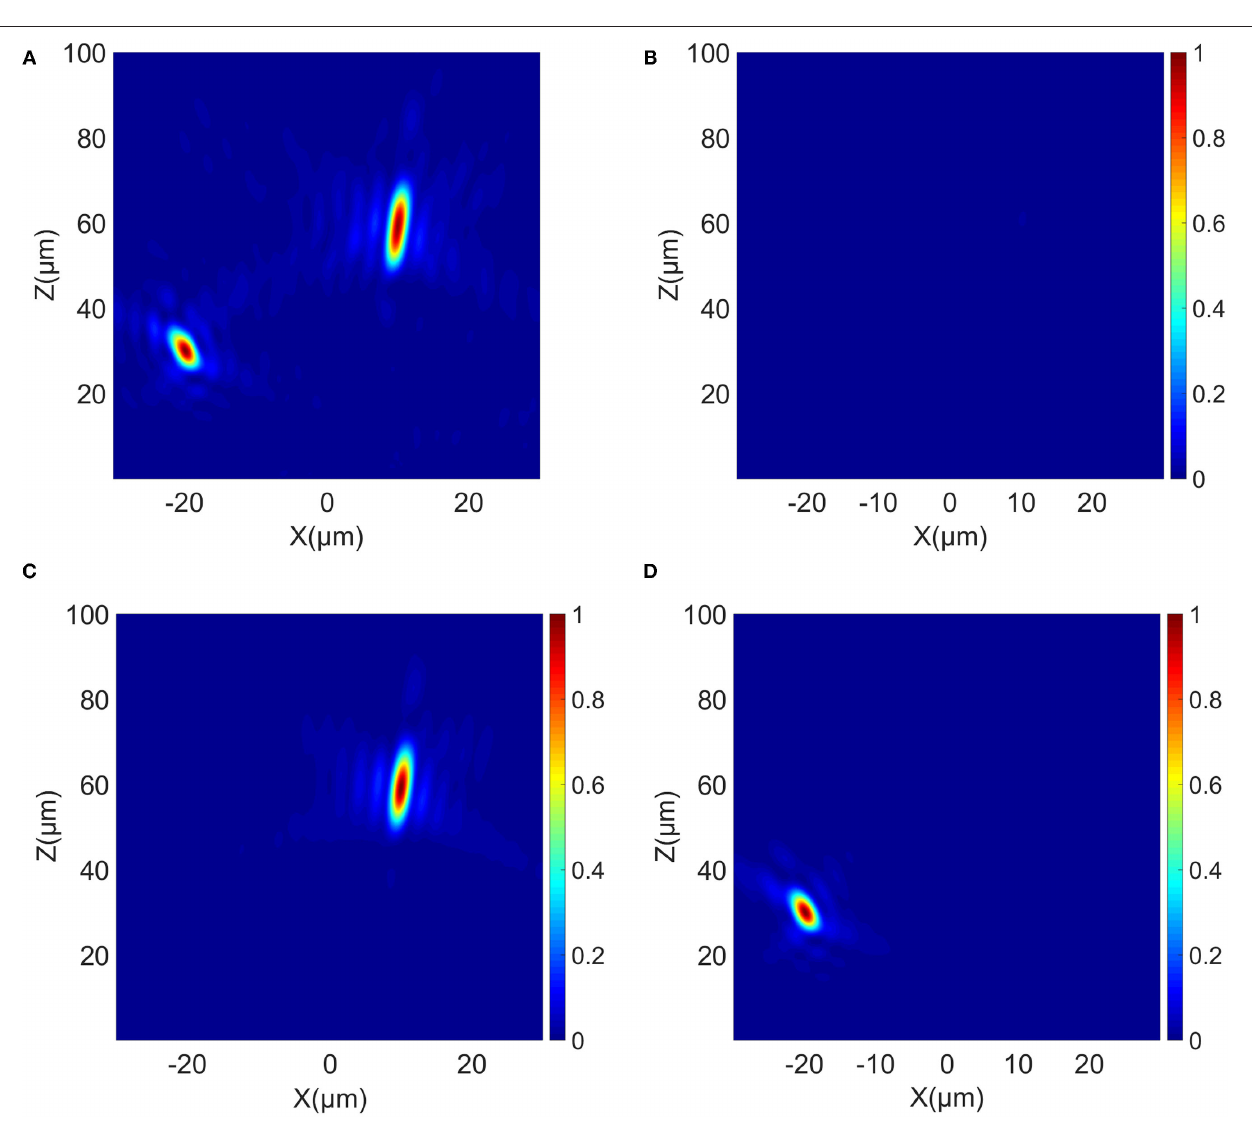
FIGURE 6 | (A–D) Electric field intensity profile for different state of VO 2 , Designed focal position: f ′ A ( pass state. (B) For x-polarized incident light in the close state. (C) For LCP polarization incident in the B pass state. (D) For RCP polarized incidence in the (A) pass